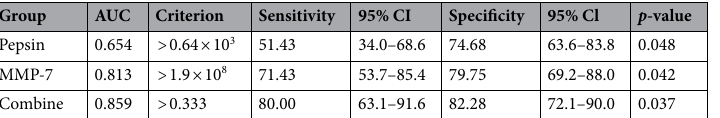
Table 1. Statistical significance of pepsin and MMP-7 according to RSI score. AUC, area under the curve; CI, confidence